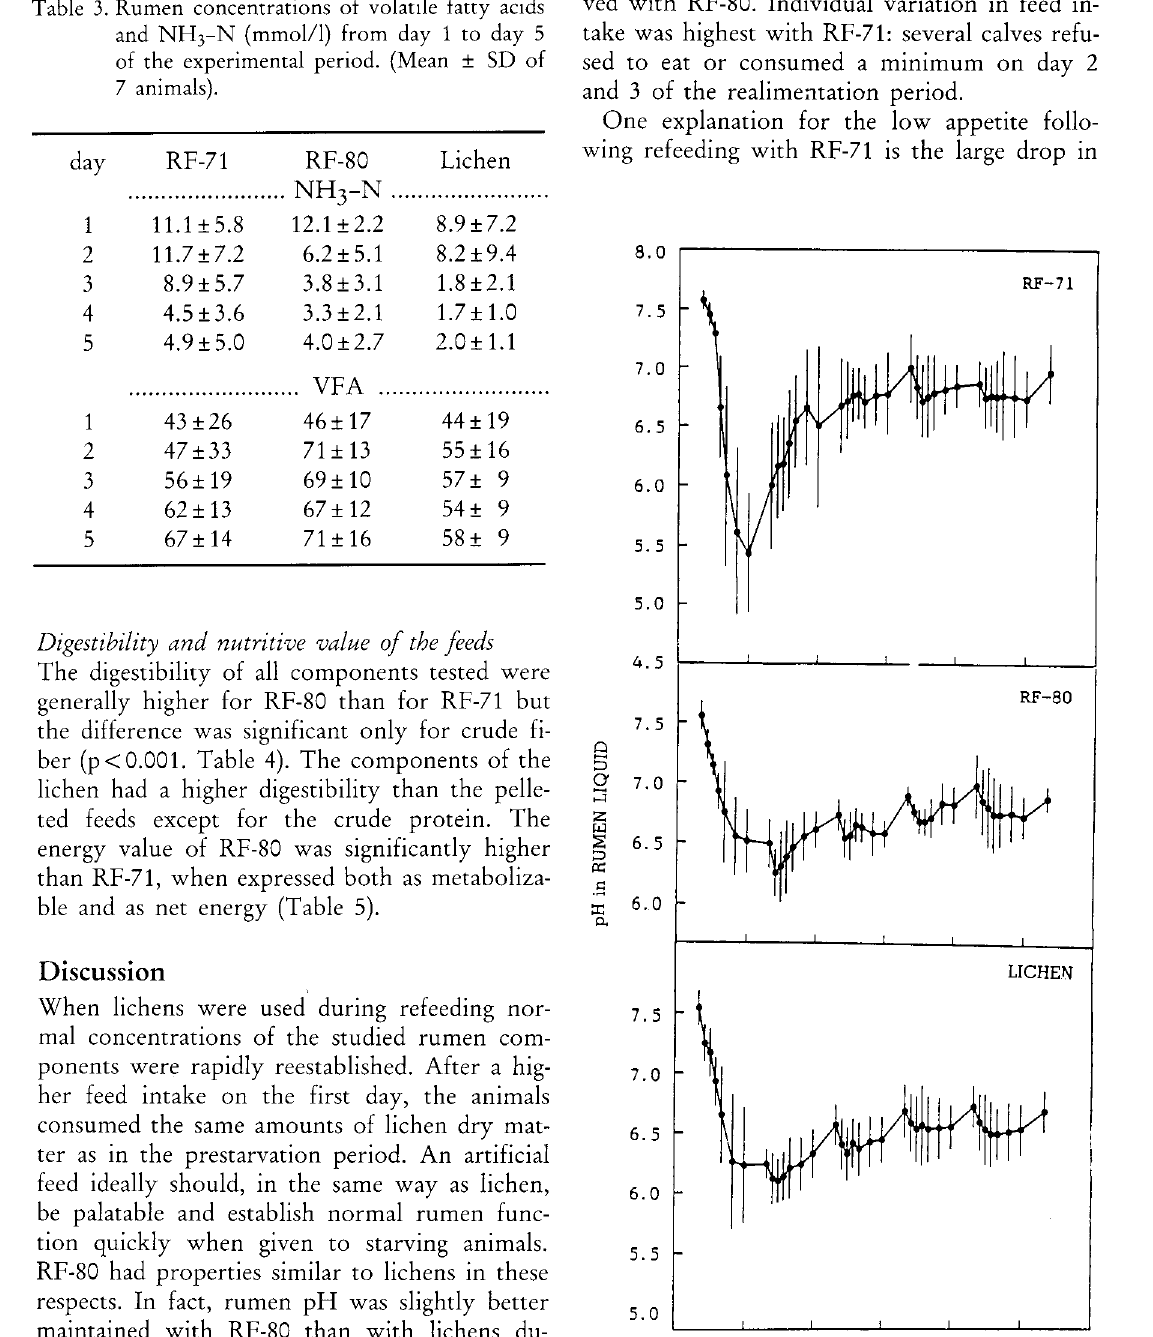
Table 3. Rumen concentrations of volatile fatty acids and N H -N (mmol/1) from day 1 to day 5 3 of the experimental period. (Mean ± SD of 7 animals).